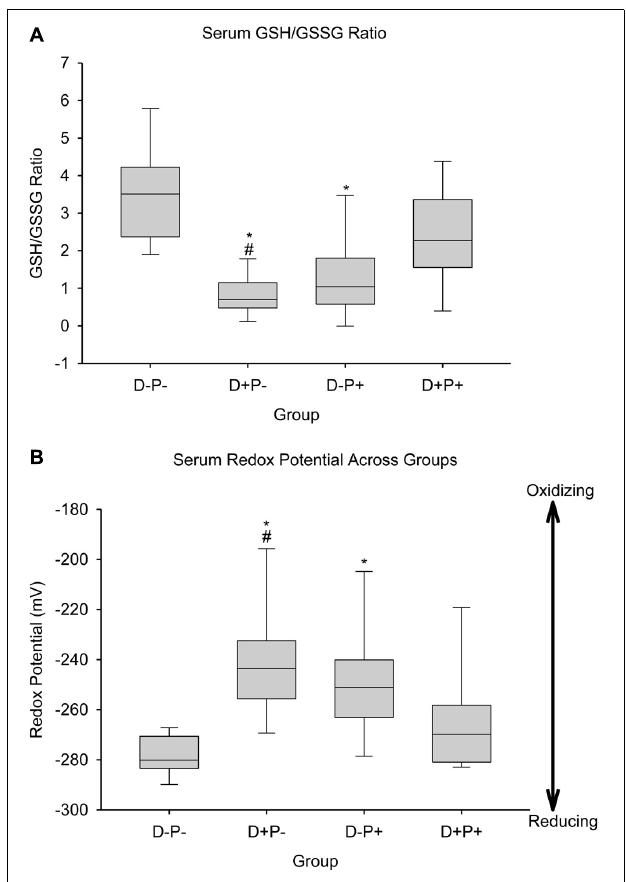
FIGURE 11 | Biochemical parameters reflecting oxidative consumption of glutathione. (A) Serum GSH/GSSG ratio and (B) Serum redox potential of the glutathione pair. Data for serum GSH/GSSG ratio and redox potential of the serum glutathione pair are shown as boxes (25–75% percentiles) and whiskers (min to max values) for each group, with inside line indicating the median of each group. n = 10–13 rats per group; ∗ p < 0.05 (Relative to D − P − ); # p < 0.05 (Relative to